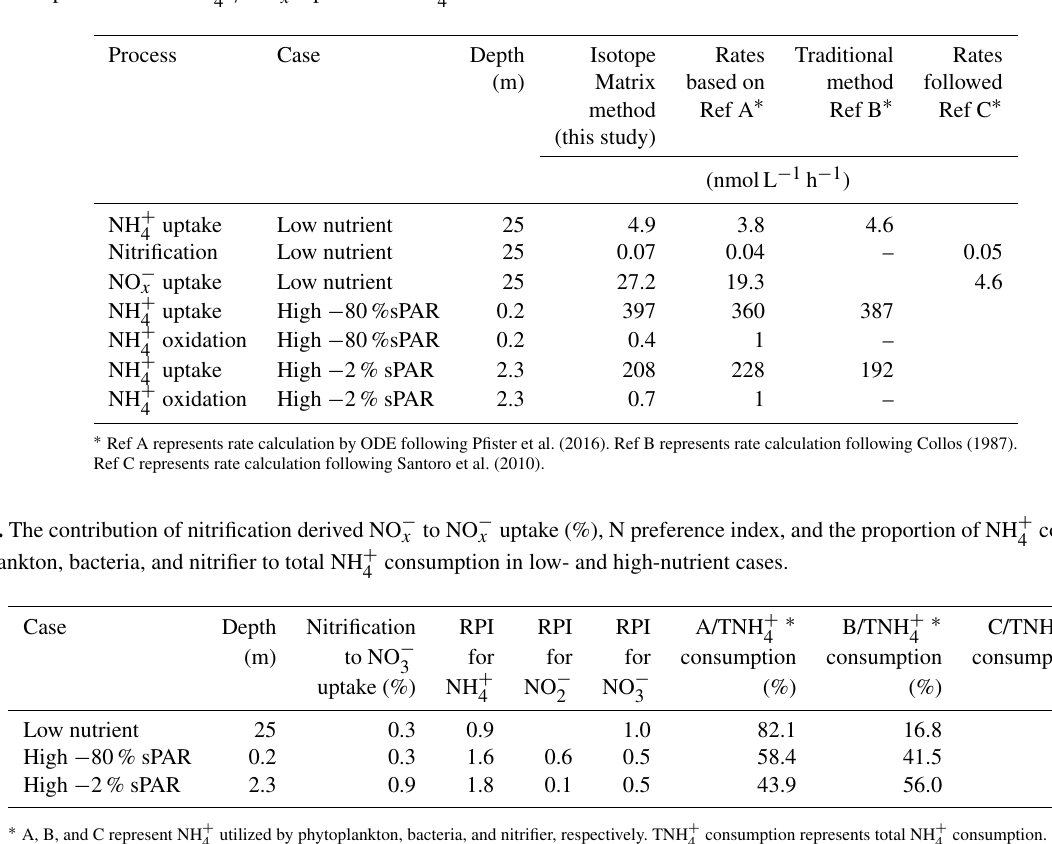
Table 3. Comparison of the NH +